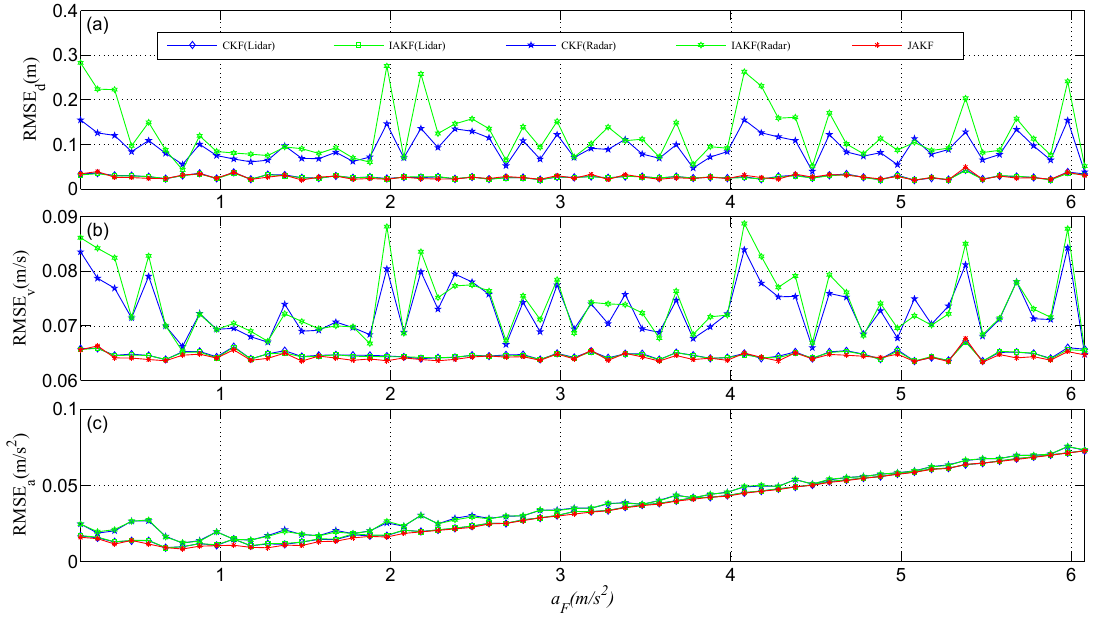
Figure 4. Comparisons of motion state estimation against different accelerations a F : ( a ) The displacement estimation; ( b ) The velocity estimation; ( c ) The acceleration estimation.